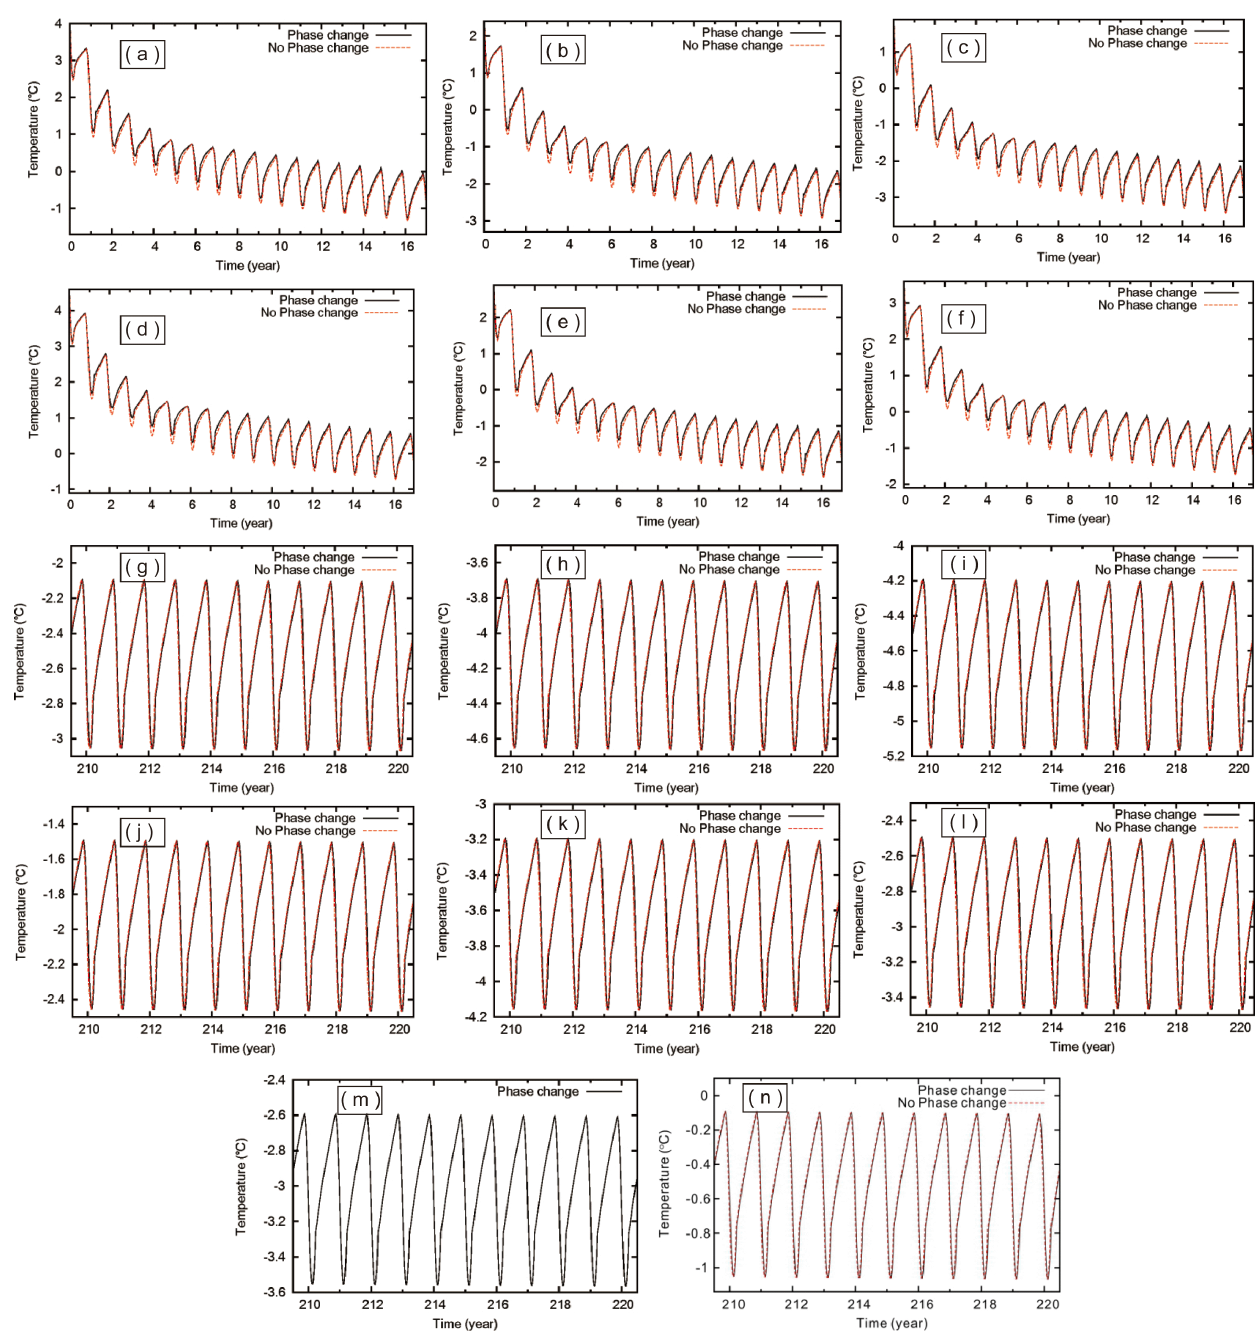
Figure 7. (a–f) Initial formation process of Ningwu ice cave in different sensitivity experiments. (g–l) Corresponding quasi-stable state. (m) Sensitivity experiment featuring density of tourists and light bulbs. (n) Quasi-stable state when the mean annual temperature increases by 3.5 ◦